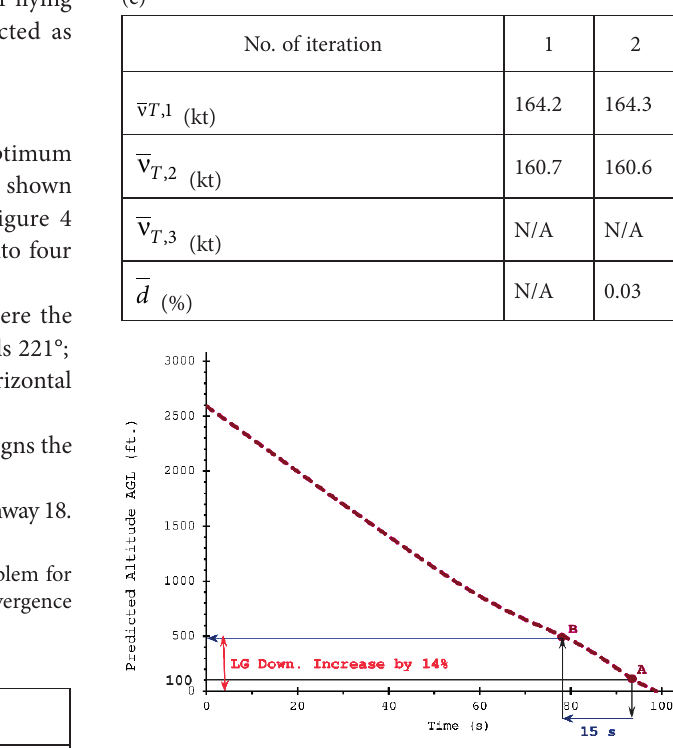
Fig. 3. Computation of additional altitude loss due to the landing gear